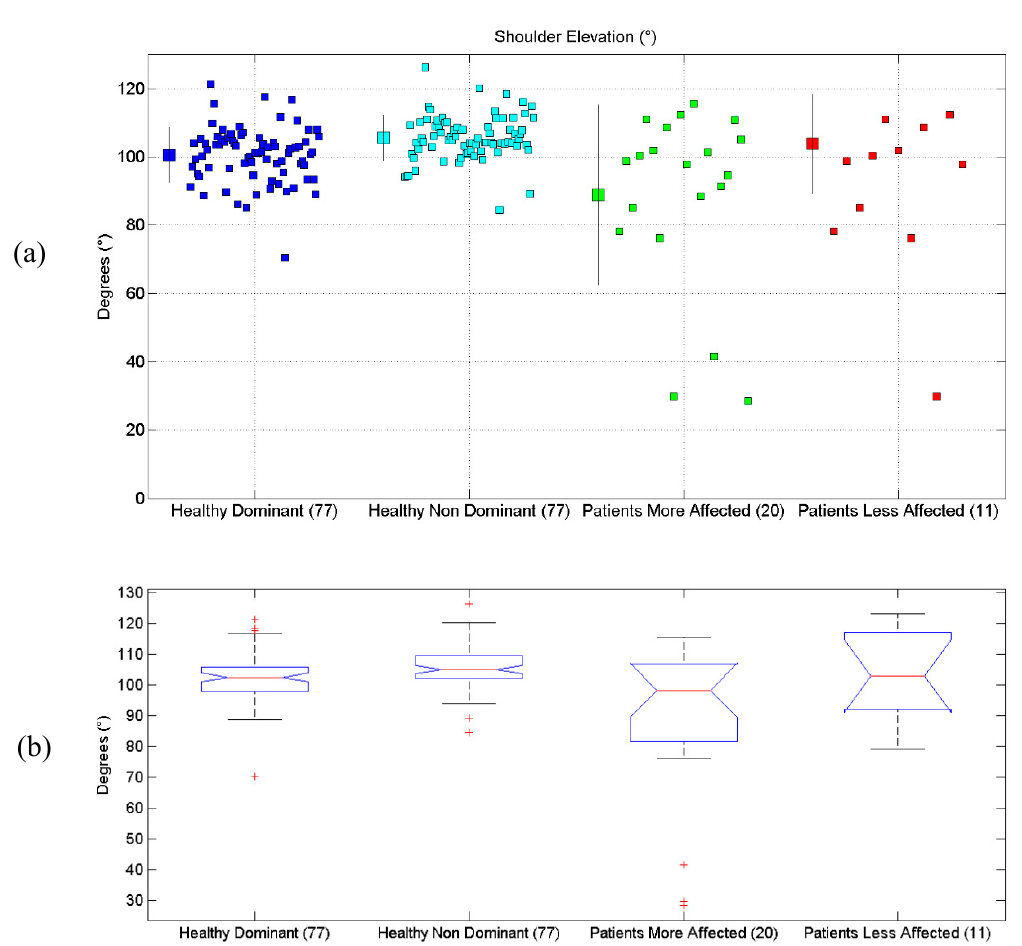
Figure 4. ( a ) Scatterplot for Shoulder Elevation Angle for the four considered groups. Mean (SD) of each population (considered limb), are reported. ( b ) Distributions of Shoulder Elevation Angle, are shown for the four experimental conditions. The central line indicates the median, while the lower and upper extremities of the boxes represent the 25th and 75th percentiles, respectively. The whiskers comprise all the data points distribution, except the outliers, which are plotted separately, using the ‘+’ mark.